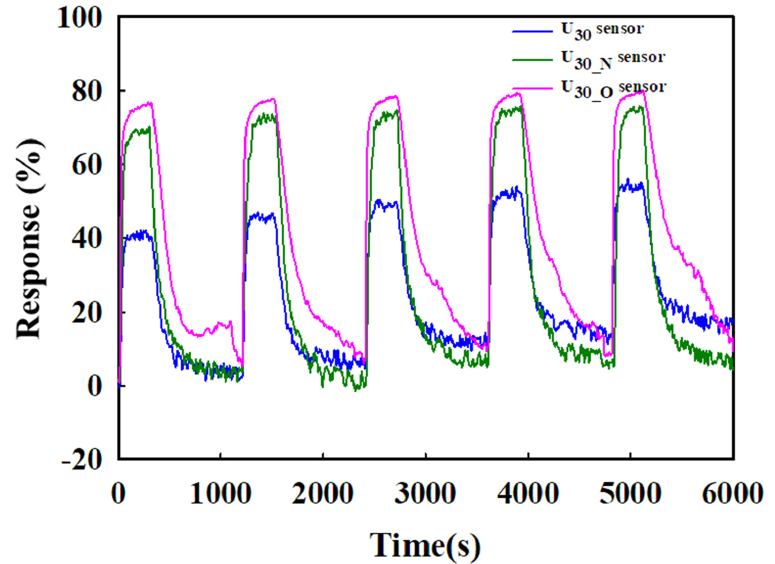
Figure 7. Reproducibility evaluation of U 30 , U 30-N , and U 30-O against 20 ppm toluene.